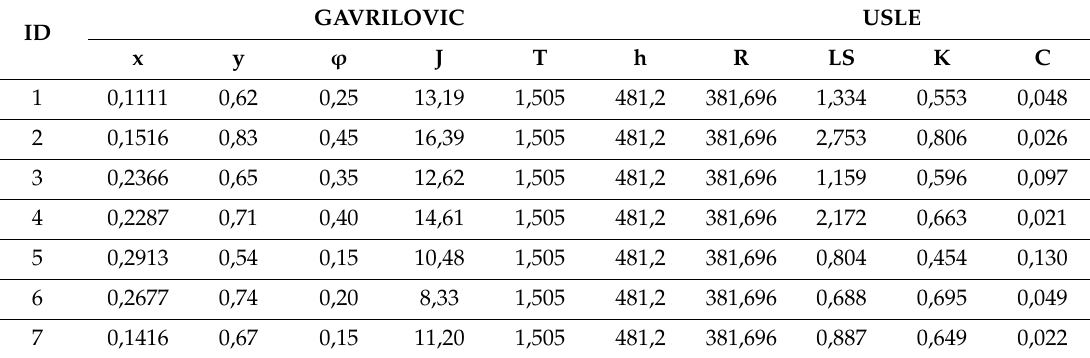
Table 1. Values of factors of the Gavrilovic and universal soil loss equation (USLE) methods. ID